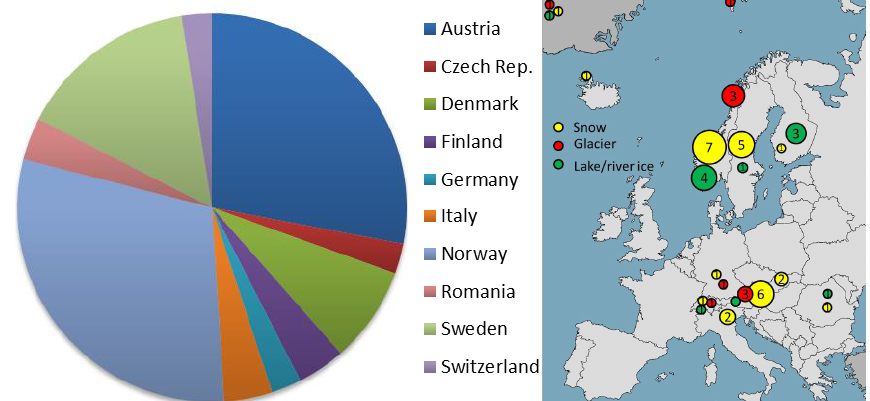
Figure 2. Nationalities of the users that responded to the user survey (left panels). Right panels: location of the users and their field of interest. Dots are scaled according to the number of respondents.